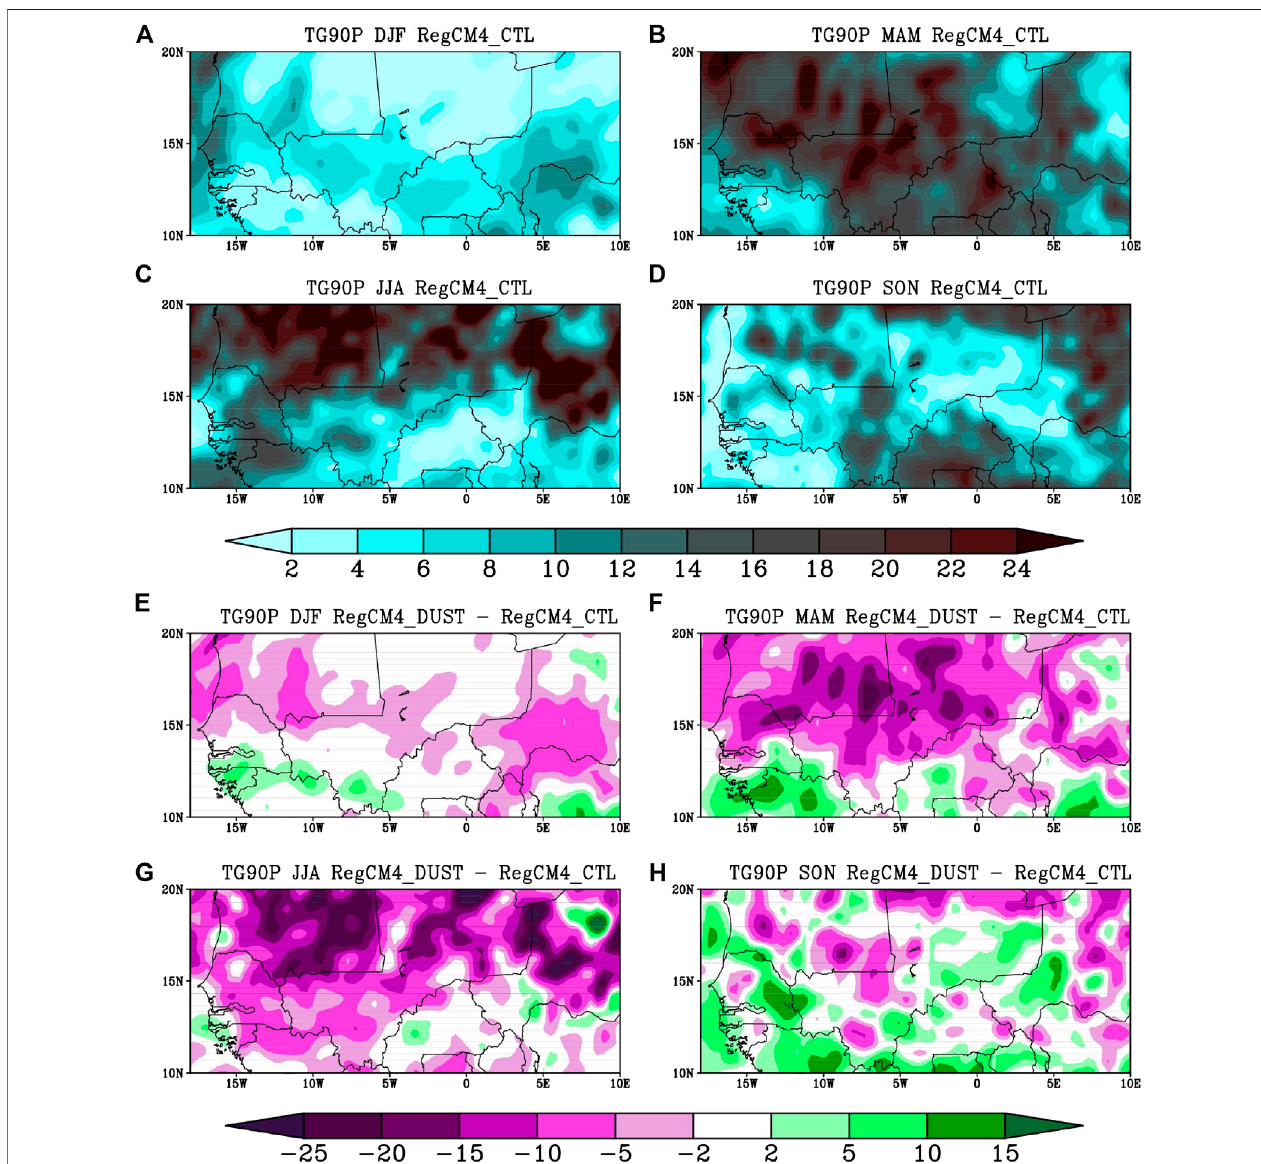
FIGURE 5 | Seasonal variability of the percentage of warm days (TG90P) averaged from 2001 to 2010 over the Sahel: (top) RegCM4_CTL, (down) difference between RegCM4_DUST and RegCM4_CTL. The differences are signi fi cant at 95% level using the Student test.